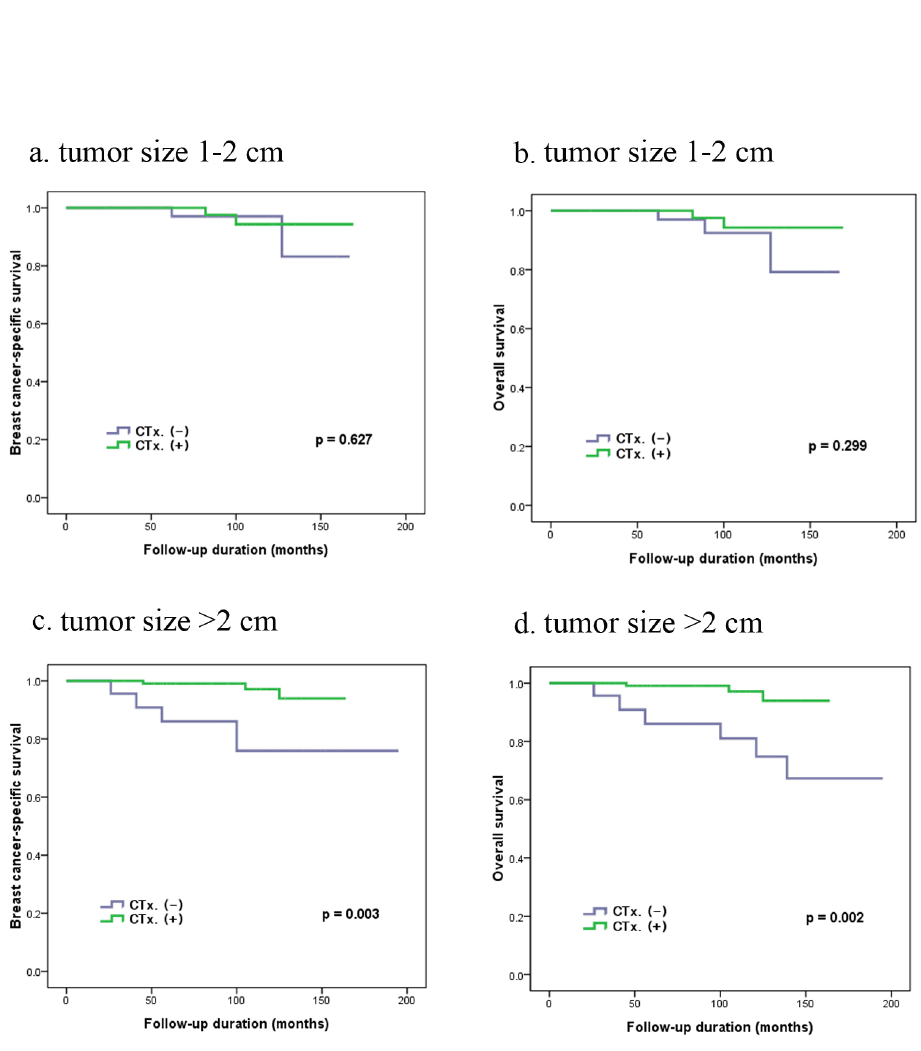
Fig 2. The association between adjuvant chemotherapy (CTx.) and survival (breast cancer-specific survival and overall survival) in the subgroup analysis according to tumor size (a,b) patients with tumor size 1 – 2 cm (c,d) patients with tumor size > 2